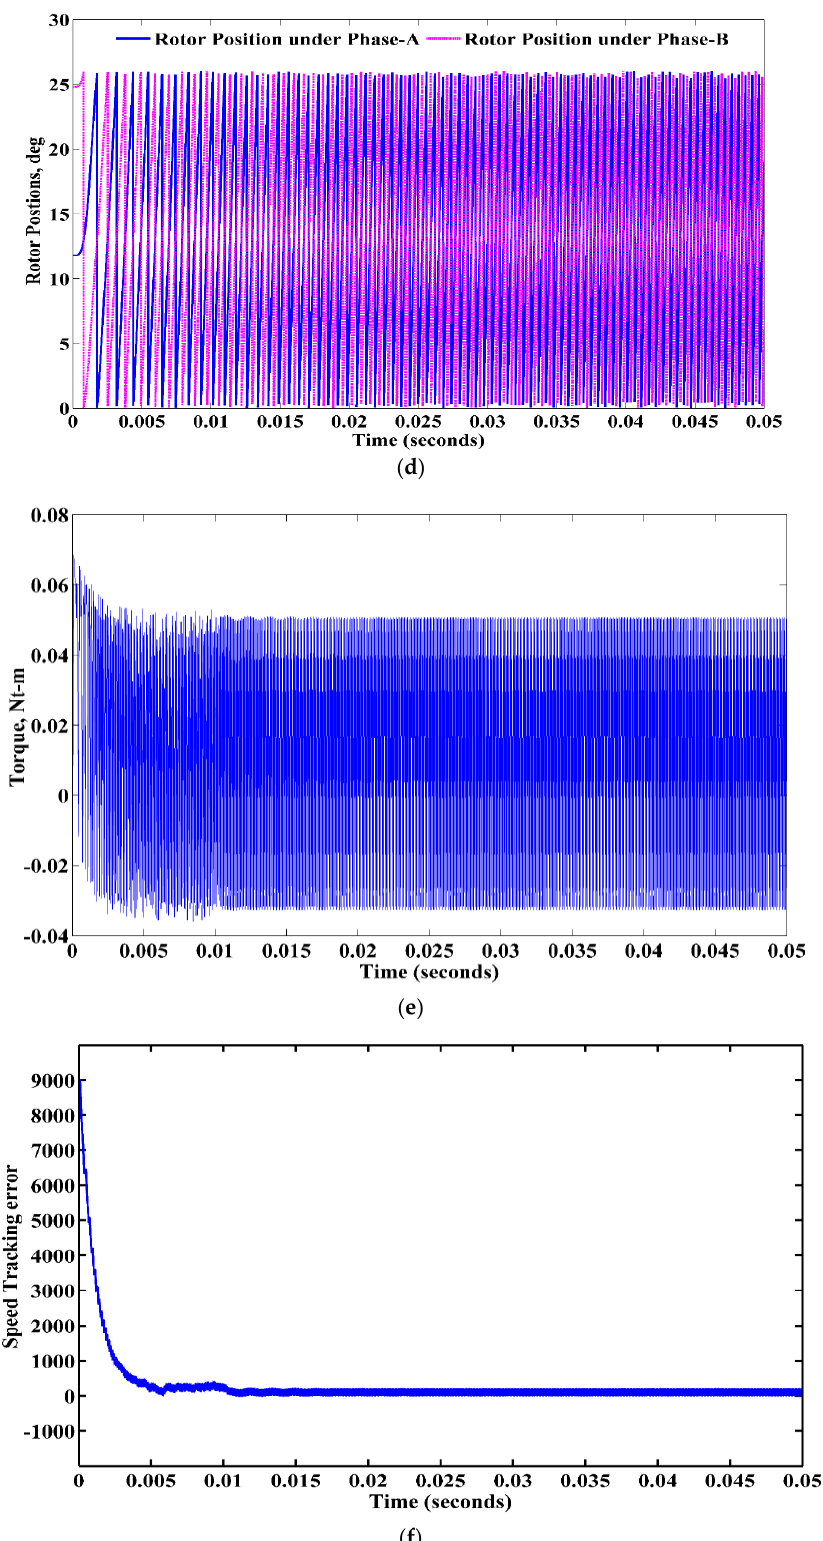
Figure 12. Motors parameters of BSRM. ( a ) Resultant speed; ( b ) Two-phase (Phase-A and B) controlled voltages; ( c ) Two-phase (Phase-A and B) controlled currents; ( d ) Rotor positions; ( e ) Resultant net torque; ( f ) Speed-tracking error.